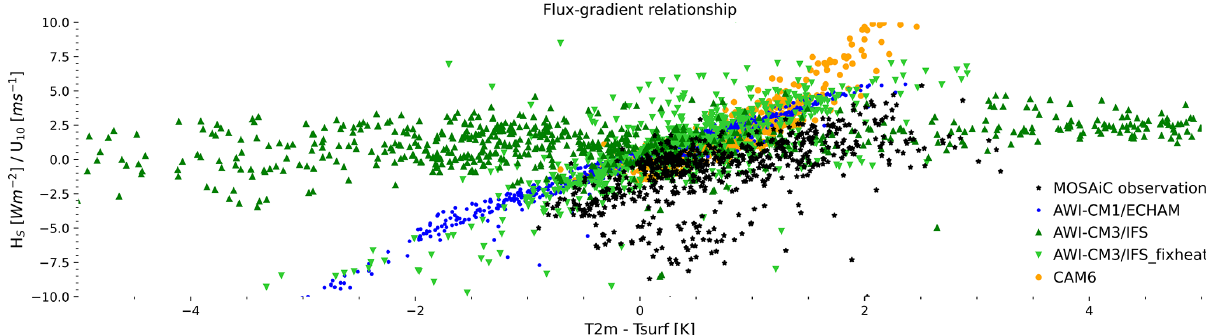
Figure 8. Relationship between near-surface temperature gradients and sensible heat fluxes (positive downwards) using hourly